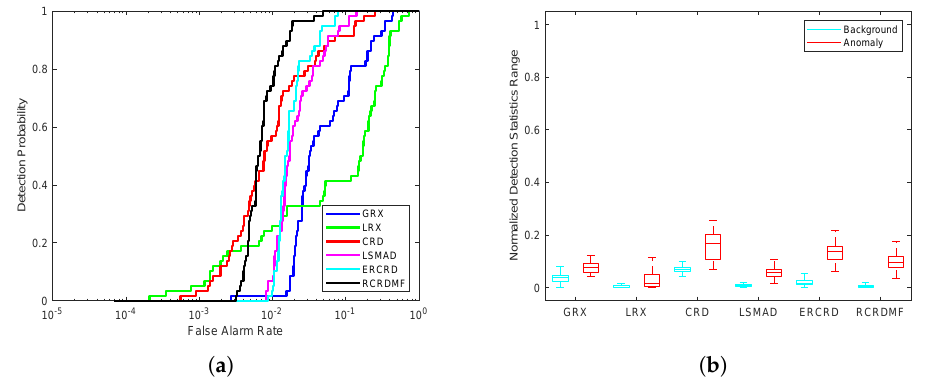
Figure 6. Detection accuracy evaluation for the AVIRIS-I dataset. ( a ) Receiver operating characteristic (ROC) curves. ( b ) Normalized background-anomaly separation